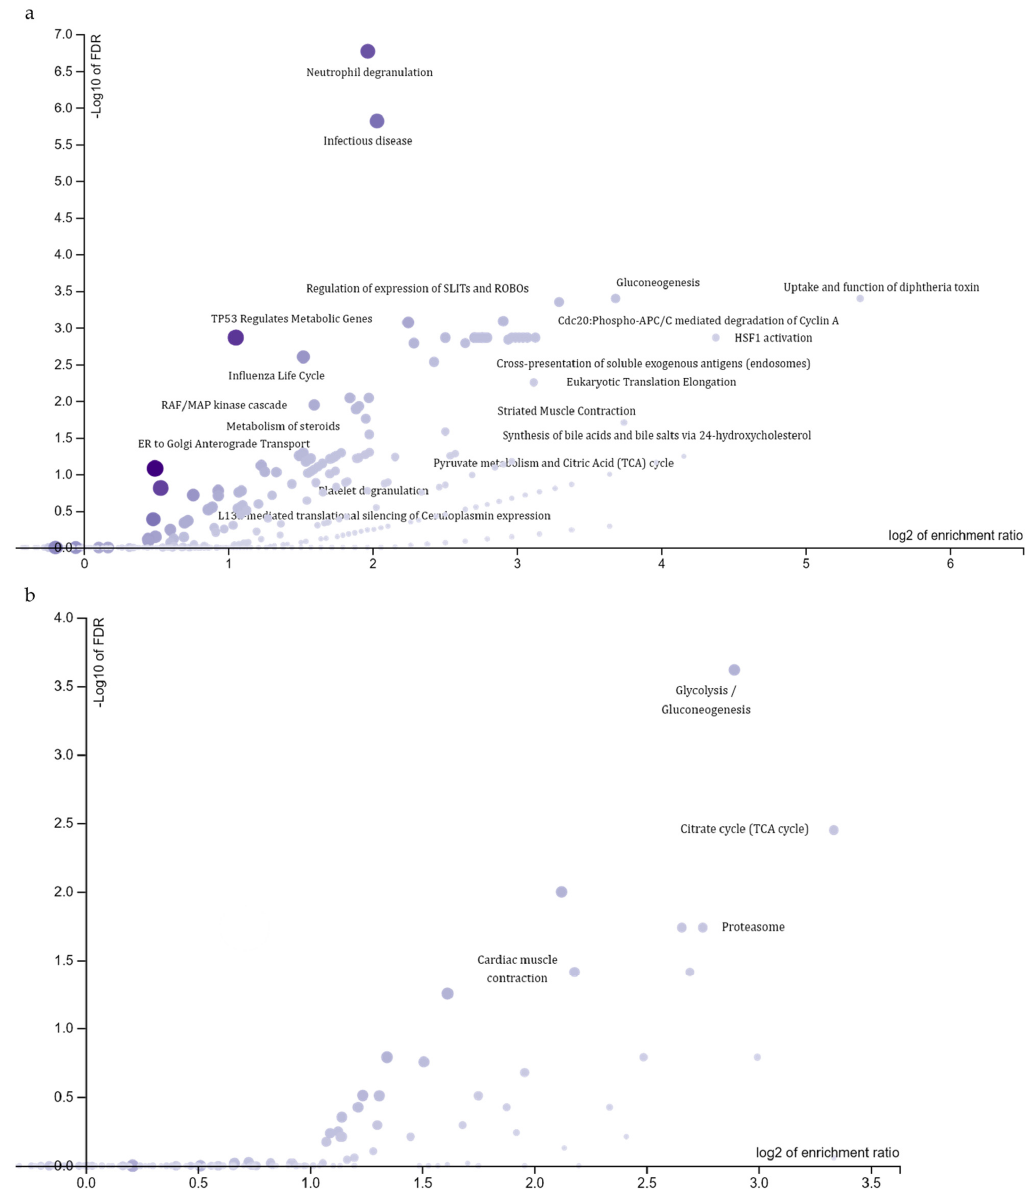
Figure 4. Functional enrichment analysis of differentially expressed proteins. Volcano plots displaying the most significantly enriched terms distributed by enrichment ratio and FDR in log scale. ( a ) Reactome database, nineteen terms labelled. ( b ) KEGG database, four terms labelled.